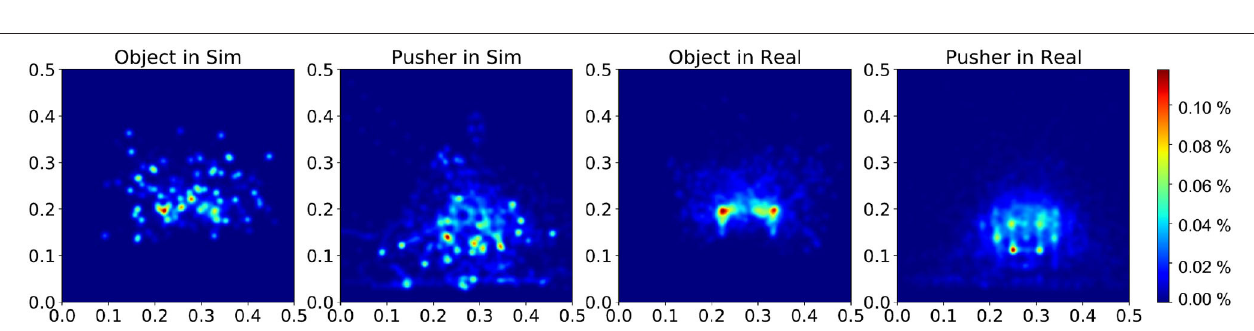
FIGURE 9 | A cuboid pushing process under human interference on the real robot platform. The object is put at an initial pose (marked with a blue box), the bottom camera takes an image and records it as the target image, which is the blue mask. The robot keeps pushing the object to the target during the whole episode. From (A–C) , we can also see that the robot is switching the pushing side as in the simulation. In (C) , the first pushing target is reached, and we give an active interference in (D) . From (D) to (F) , the robot adjusts the pusher consistently and finishes the second pushing process successfully.